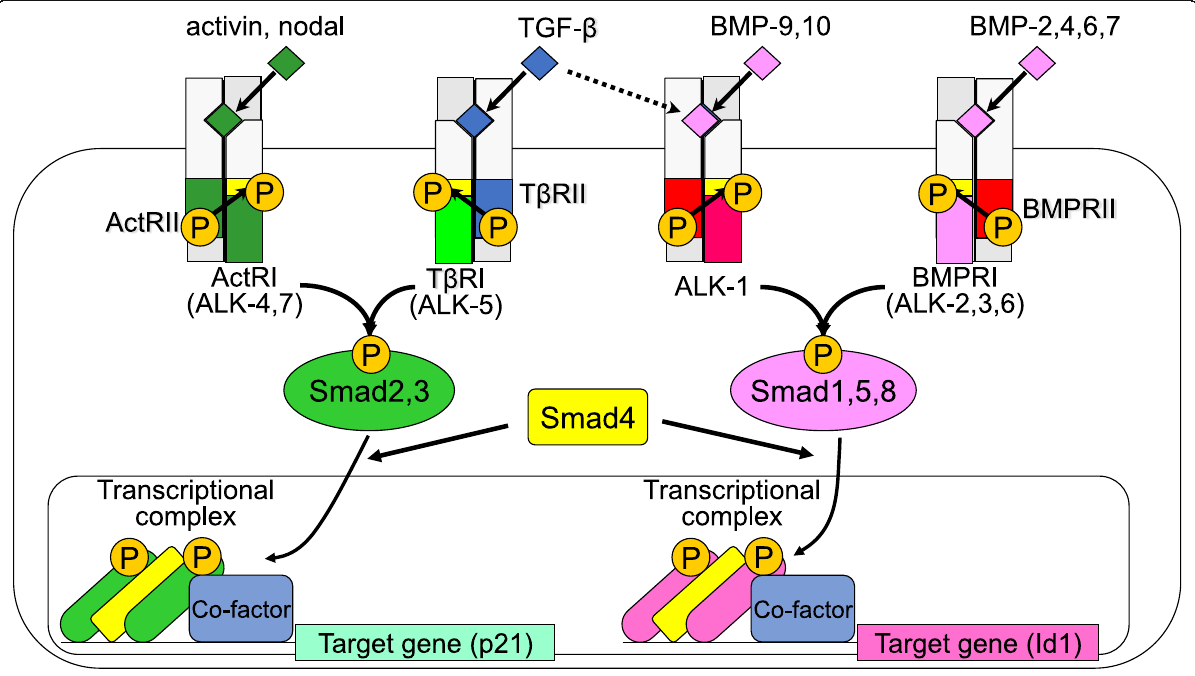
Fig. 1 TGF- β family signaling